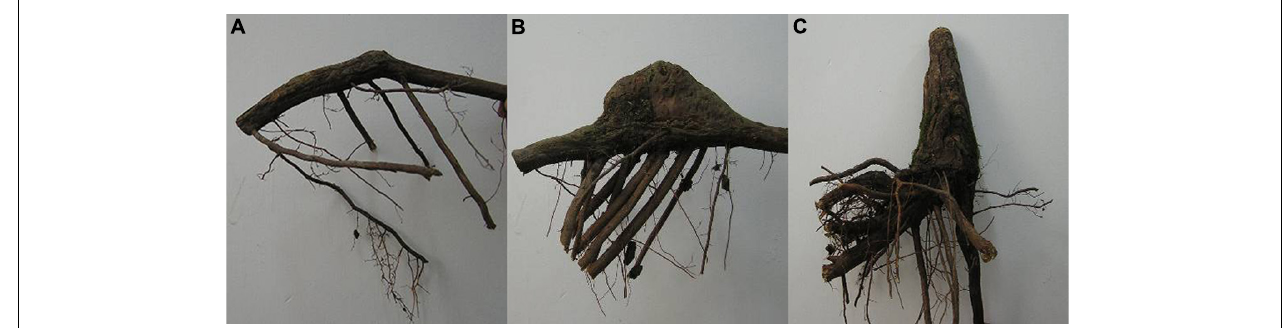
FIGURE 2 | Photographs of knee roots of young-aged stage (A) , middle-aged stage (B) , and old-aged stage (C) . The knee roots at the young-aged stage were less than 5 cm in height and less than 5 years of age. The knee roots at the middle-aged stage were 5–10 cm in height and 5–10 years of age. The knee roots at the old-aged stage were more than 10 cm in height and more than 10 years of